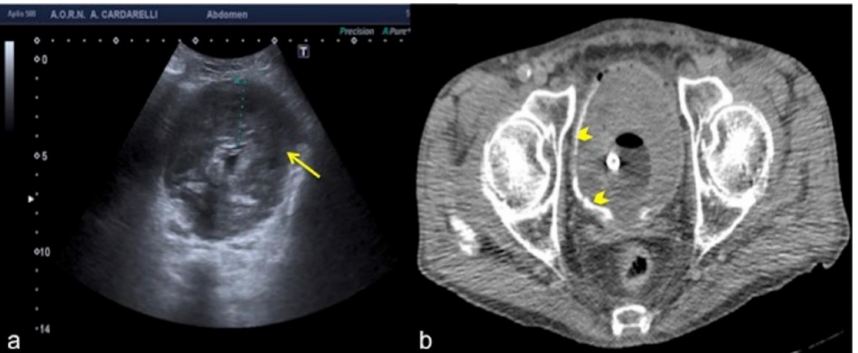
Figure 22. Transverse US scan of the epigastrium ( a ) shows a focal thickening of the aortic wall (arrow) misinterpreted as hematoma in a 45-year-old man investigated for high-dynamic deceleration trauma. On CT scan ( b ) it appears to be a hypertrophic right diaphragmatic pillar (arrow).